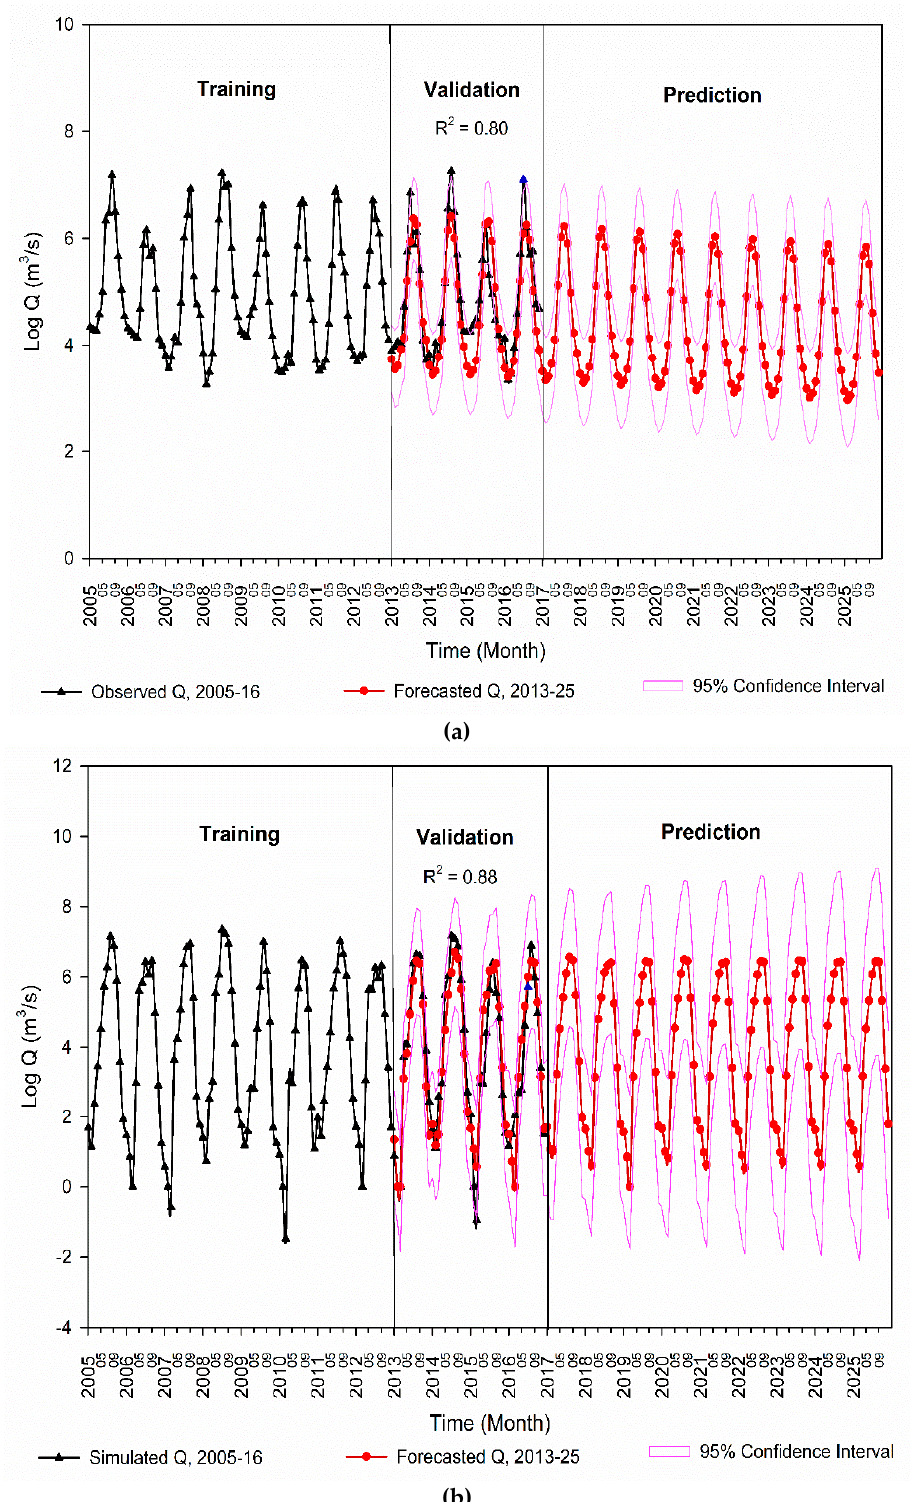
Figure 7. ( a ) Forecasted monthly Lhasa River streamflow for time span of 2013–2025 using the observed hydrological time series from 2005 to 2016. SARIMA model validation years from 2013 to 2016 are marked. ( b ) Forecasted monthly Lhasa River streamflow for time span of 2013–2025 using SWAT-simulated hydrological time series from 2005 to 2016. SARIMA model validation years from 2013 to 2016 are marked.